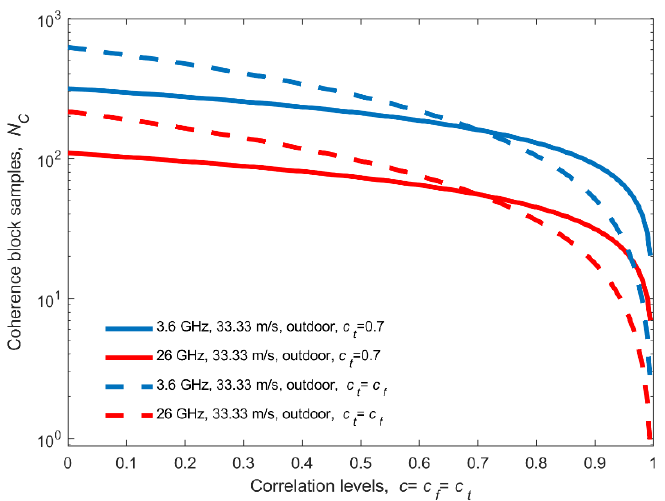
Figure 3. ChB lower bound as a function of both correlation coefficients, in frequency and time. The outdoor in car cases have been considered.